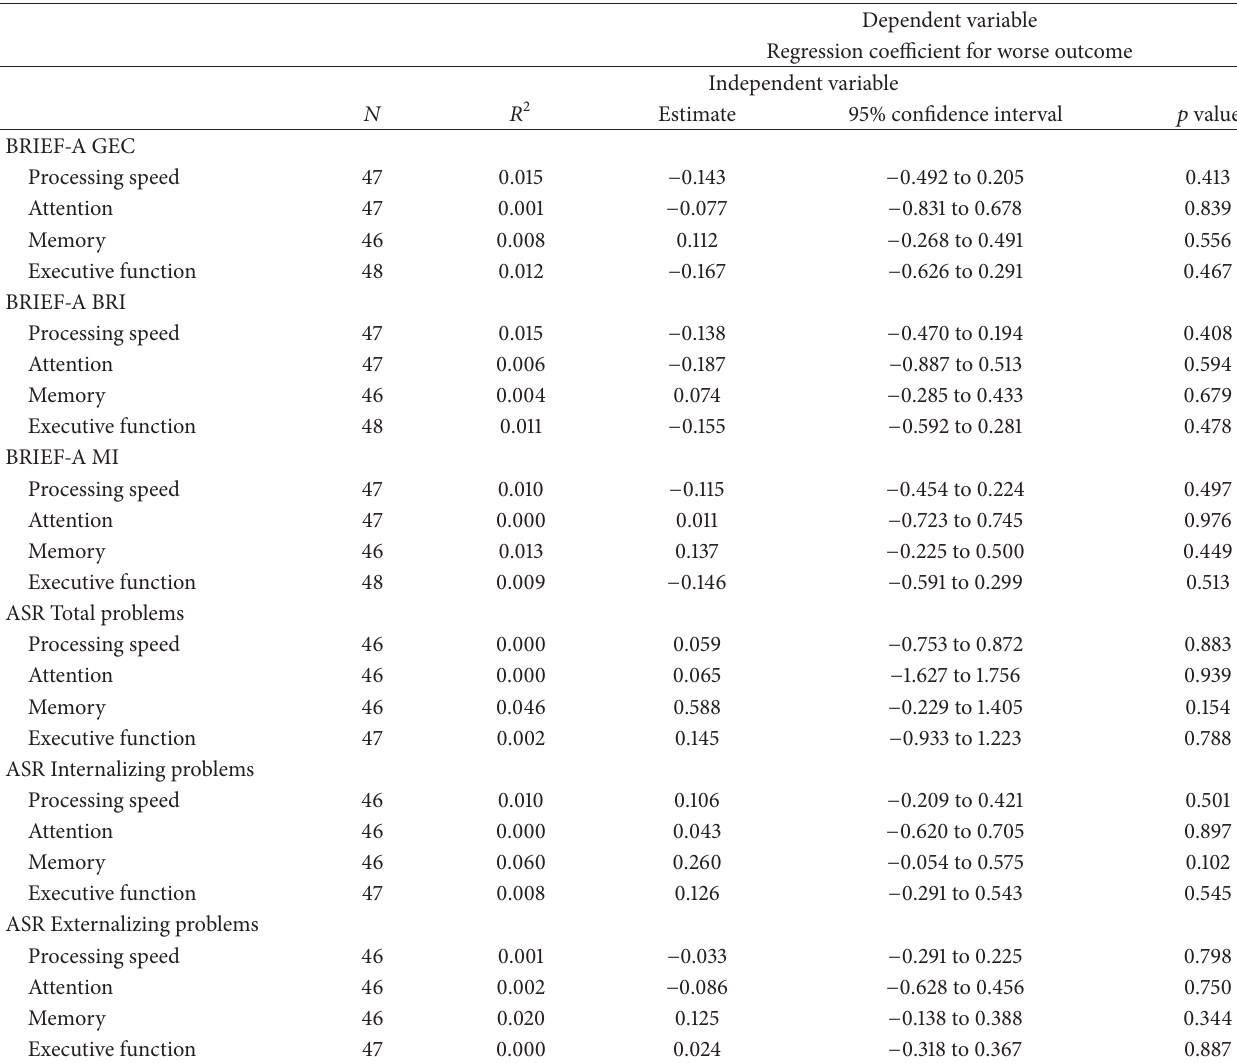
Table 8: Associations between main composite scores on BRIEF-A and ASR 2–5 years after moderate and severe TBI and neuropsychological test performance 3 months after injury ∗ .